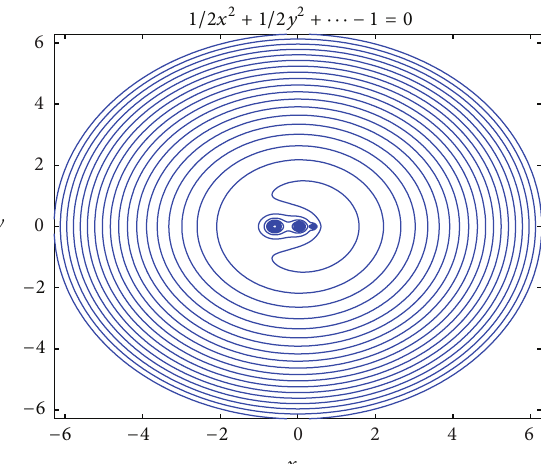
Figure 7: Curve of zero velocity (Archid-2) 𝑞 1 = 0.9971 , 𝑞 2 = = 0.01 , 𝐴 = 0.02 . 0.9997 , and 𝐴 1 2